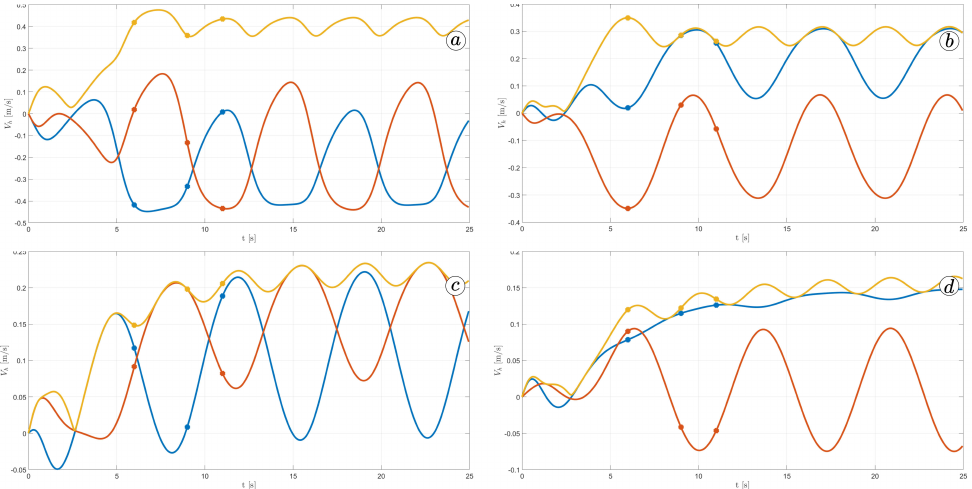
Figure 38. Velocity of the snake robot’s head for δ = 30 ◦ ( a ), δ = 40 ◦ ( b ), δ = 50 ◦ ( c ), and δ = 60 ◦ ( d